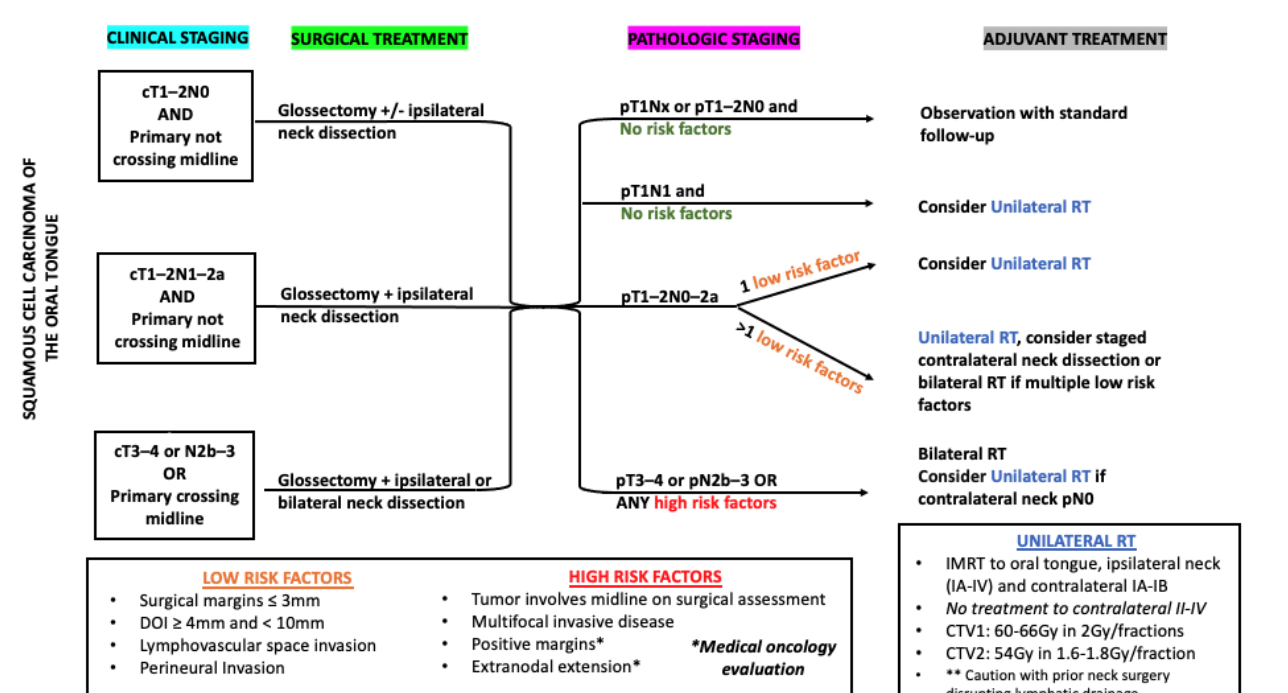
Figure 2. Proposed patient selection (on clinical trial) for unilateral neck RT for patients with squamous cell carcinoma of the oral tongue staged with PET/CT. * = Patients with tumor with positive margins and/or extranodal extension on pathology should be referred to medical oncology for evaluation for chemotherapy; ** = Unilateral radiation therapy should be delivered with caution in patients with prior neck surgery that disrupts lymphatic drainage.